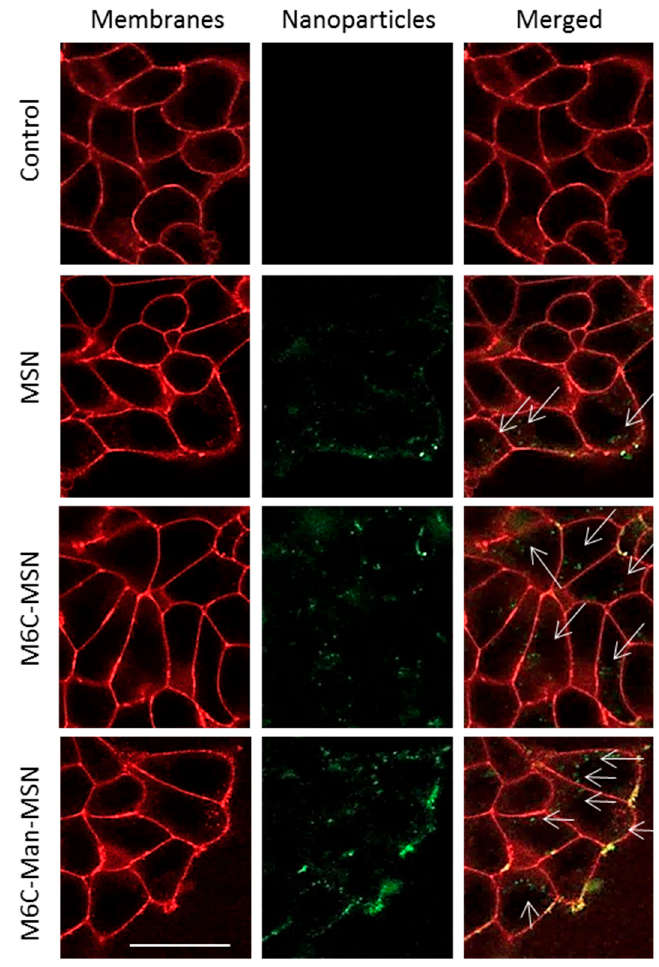
Figure 2. Fluorescence imaging of LNCaP prostate cancer cells incubated for 24 h with or without nanoparticles (Control). Cell membranes were stained with Cell Mask (red). All nanoparticles appeared here in green and were imaged with a laser Helium / Neon (7.5% power). Nanoparticles inside cells were highlighted with white arrows. Colocalization of nanoparticles and membrane appears in yellow. Scale bar: 10 µm.